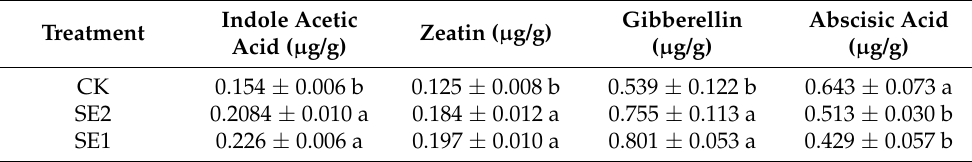
Table 6. Effects of organic fertilizer on the levels of hormones in ‘Fuji’